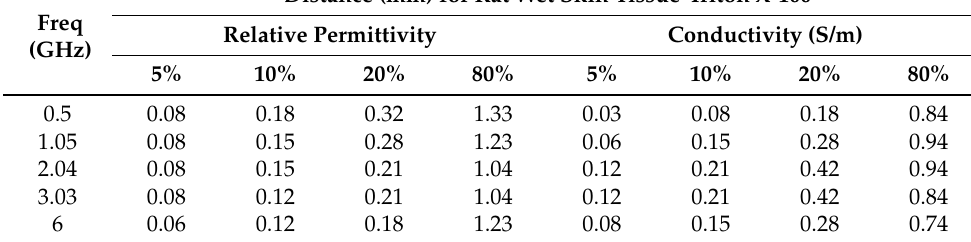
Table 9. Specified decrease levels for retrieved relative permittivity and conductivity of double- layered rat wet skin tissue and triton X-100 configuration and the corresponding distances (D n ) at 0.5, 1.05, 2.04, 3.03 and 6 GHz frequency